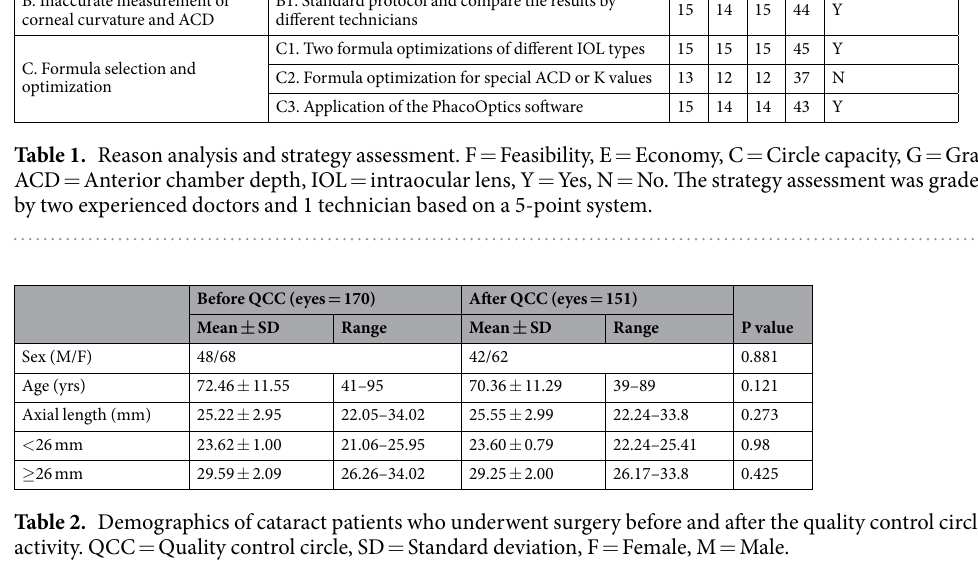
Table 3 summarized the refractive outcomes of Haigis and SRK/T formulas in patients with different AL in the two groups. As shown in Table 4, there was significantly higher